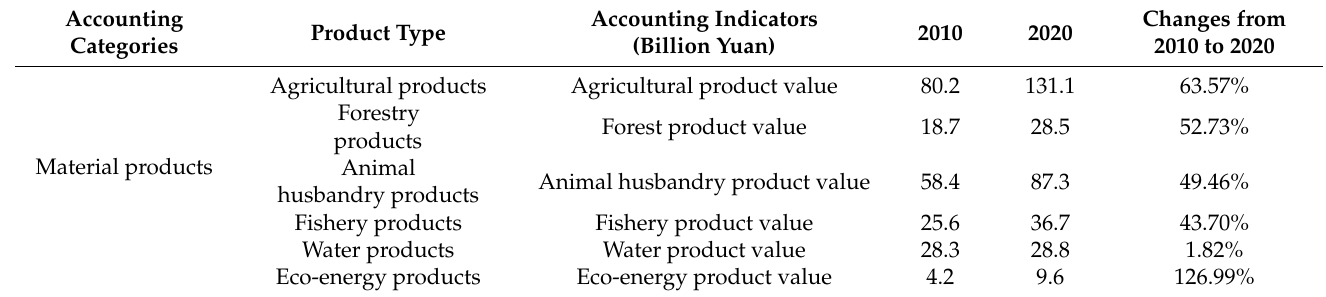
Table 5. Changes in the value of ecological material products in Jiangxi Province